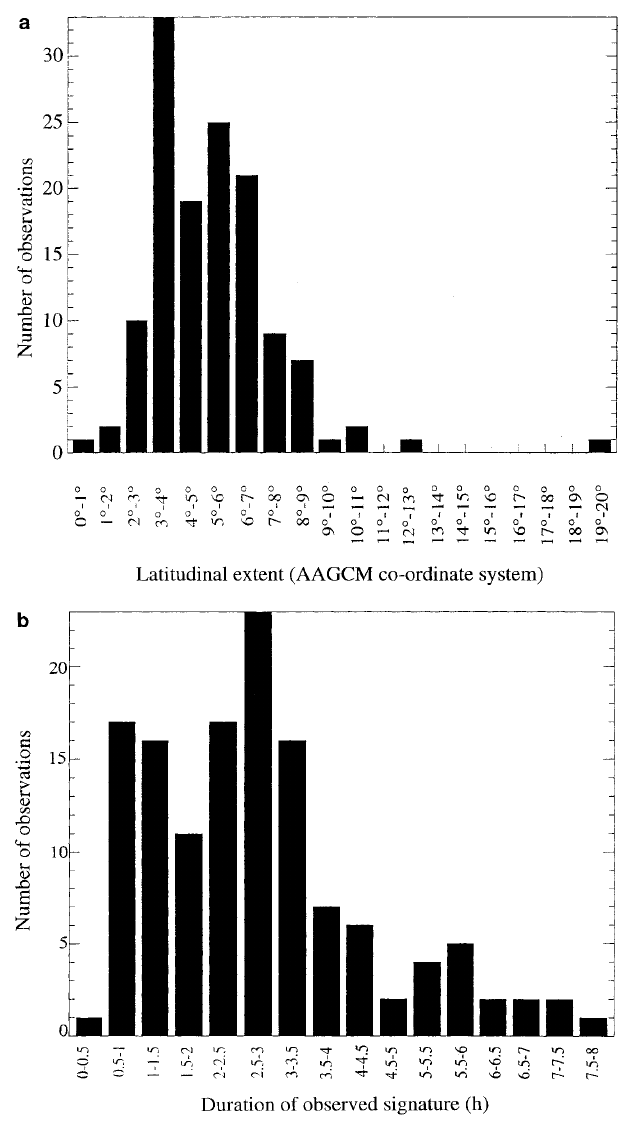
Fig. 5a, b. Distribution of a the magnetic latitudinal extent and b MLT duration of PIF signatures observed by beam 5 of the CUTLASS Finland radar, for the subset of events observed when the radar was run in a normal scan mode